Question: Judging by this figure, is the value going up or going down?
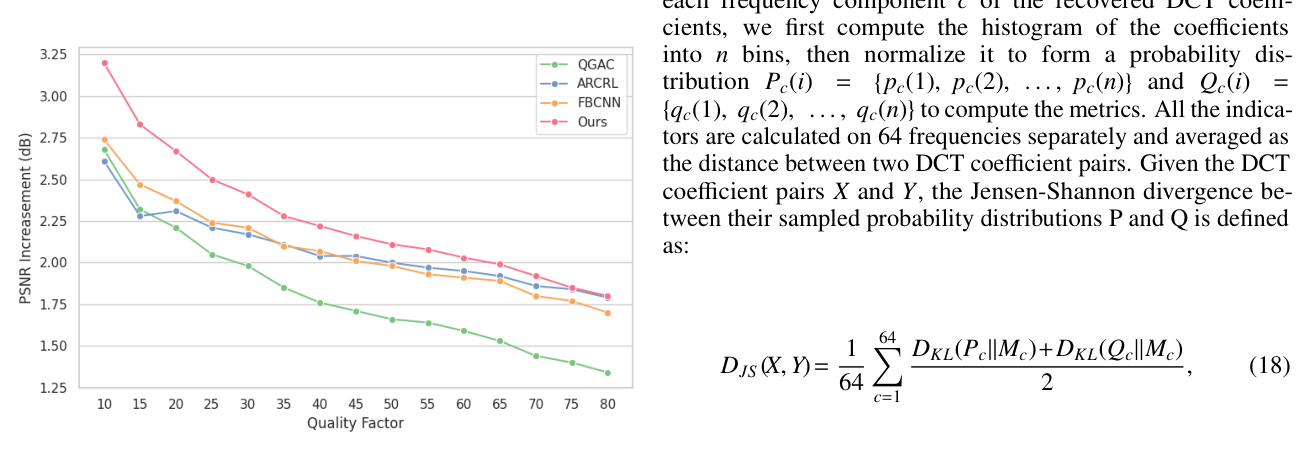
Answer: increasing